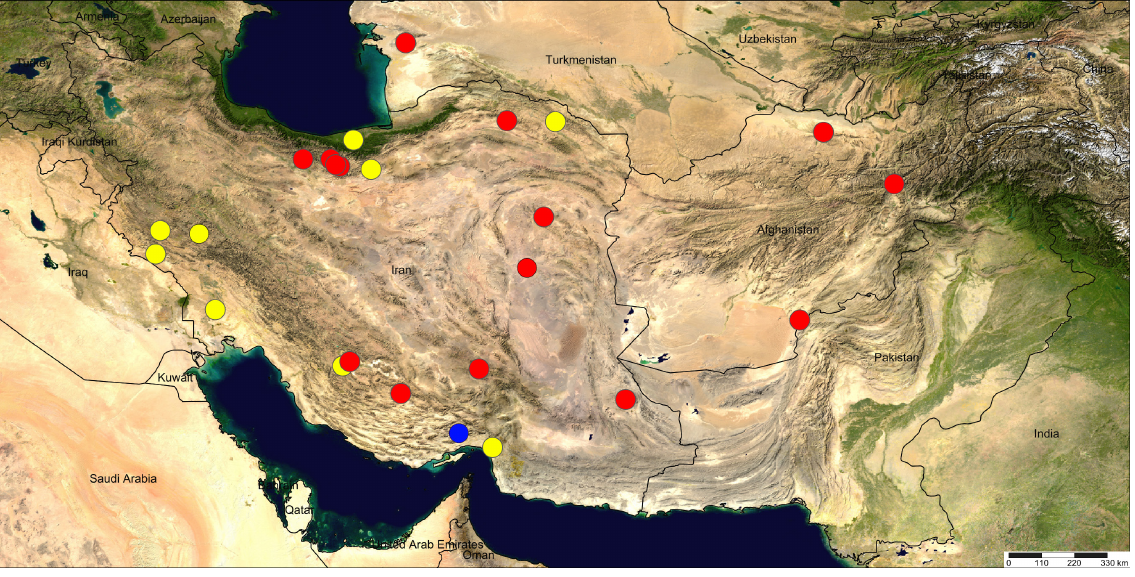
Fig. 2. Distribution of Uroctea Dufour, 1820 in Iran, Afghanistan and Turkmenistan. red circles = U. grossa Roewer, 1960; yellow circles = U. thaleri Rheims, Santos & van Harten, 2007; blue circle = U. gambronica sp.